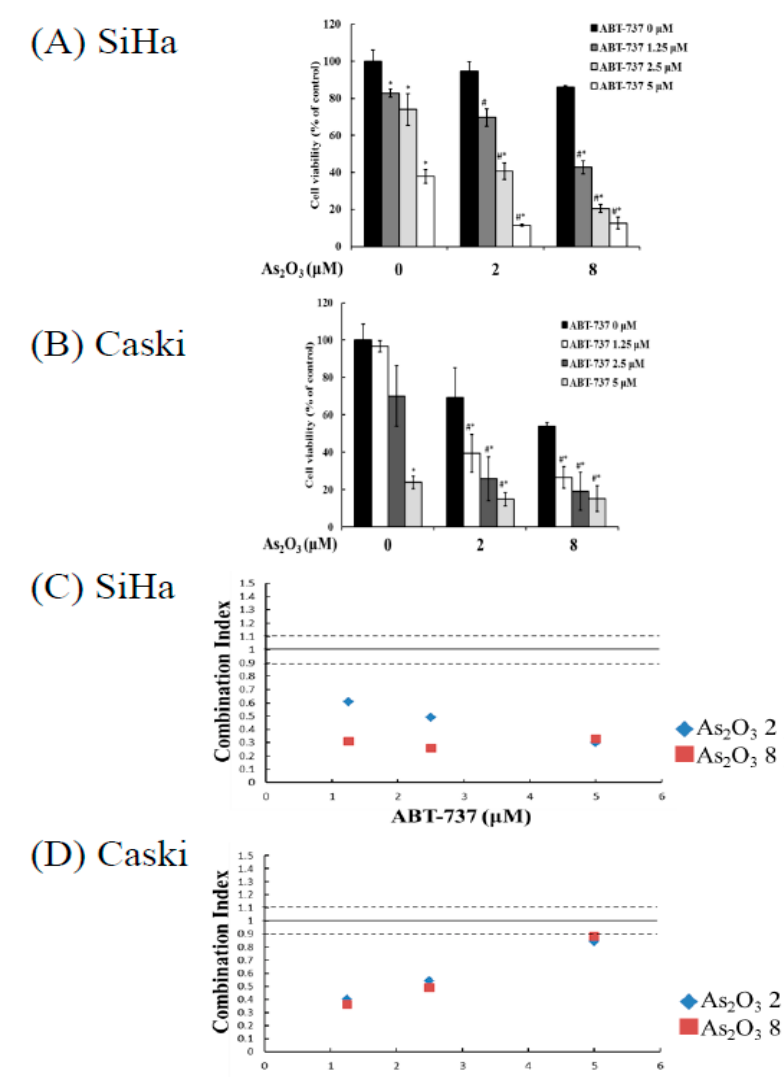
Figure 1. Effects of ABT-737 and As 2 O 3 on cell viability in cervical cancer cells. ( A ) SiHa (5 × 10